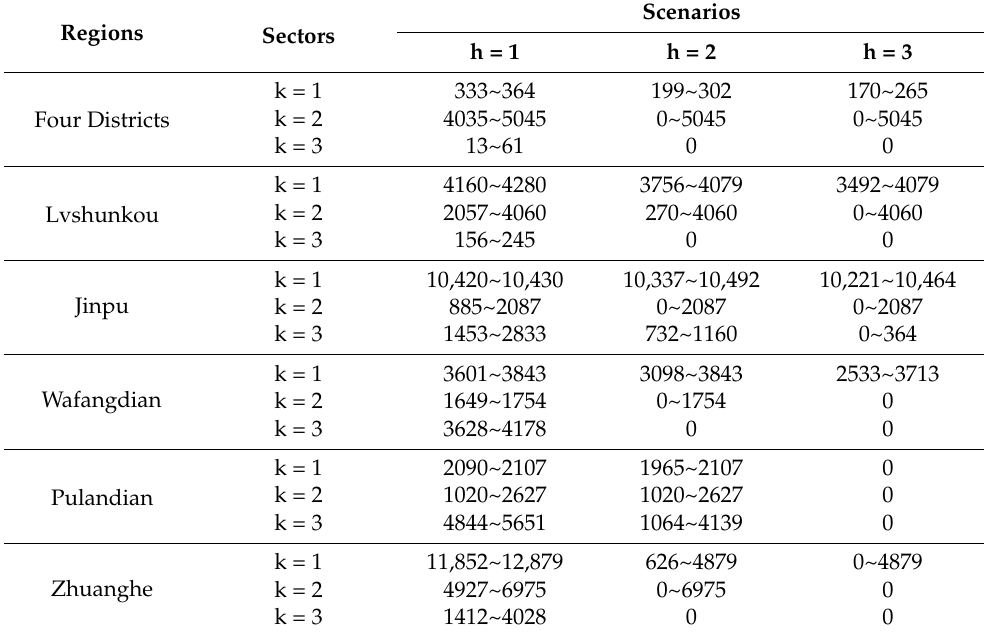
Table 5. Upper and lower bounds of water resource deficit for each sector under different scenarios in period 3 (10 4 m 3